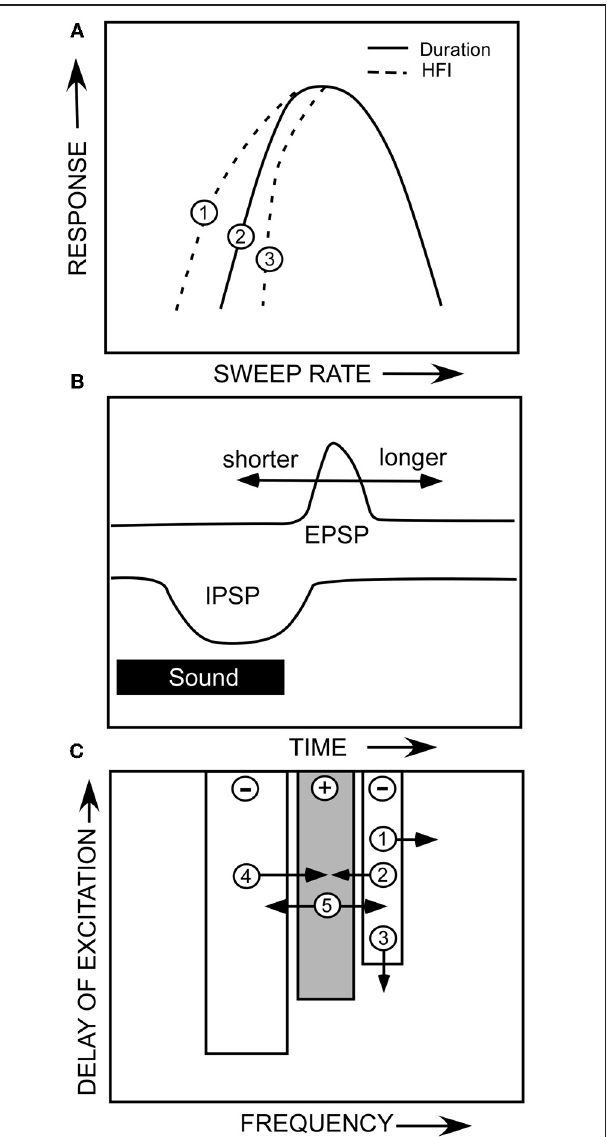
FIGURE 9 | Application of GBZ was ineffective at eliminating bandpass duration tuning (A), HFI (B), or band-pass FM rate selectivity (C) in this neuron.